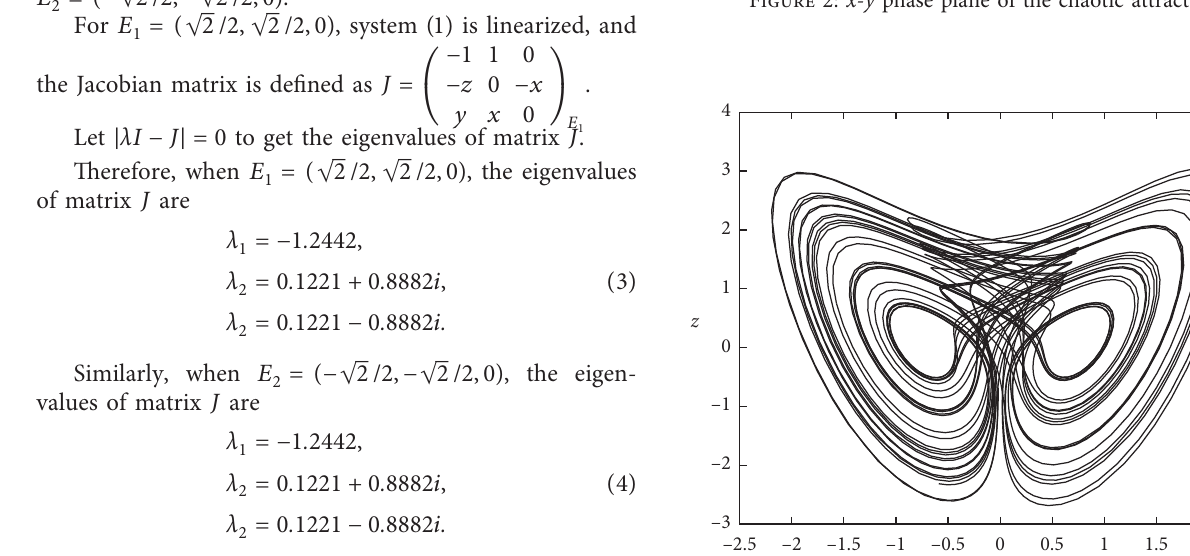
Figure 2: x - y phase plane of the chaotic attractor.